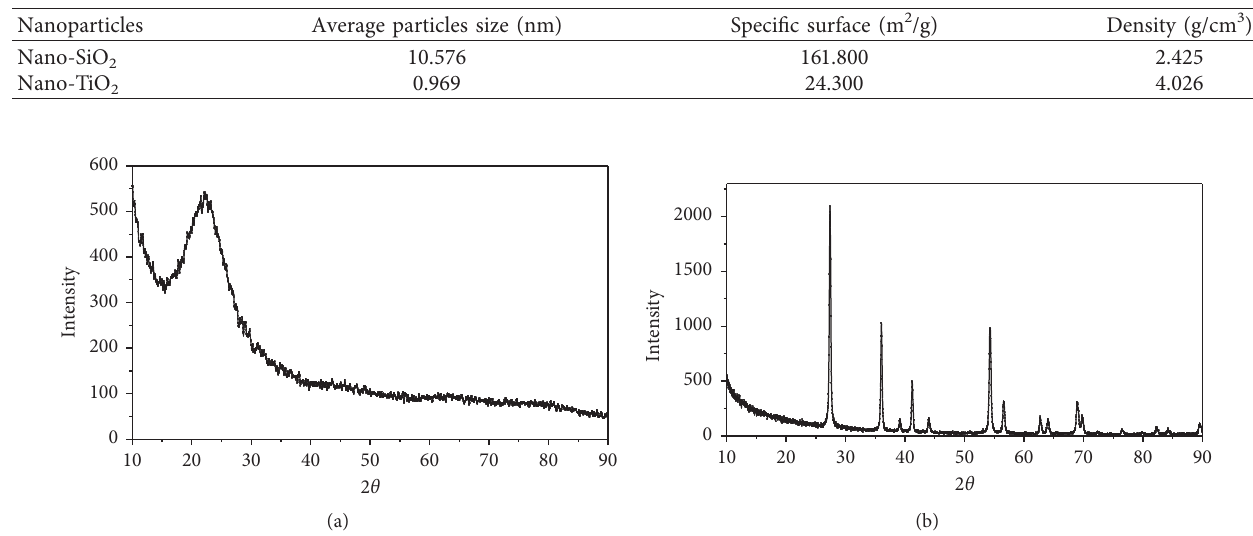
Table 1: Physical properties of nanoparticles.